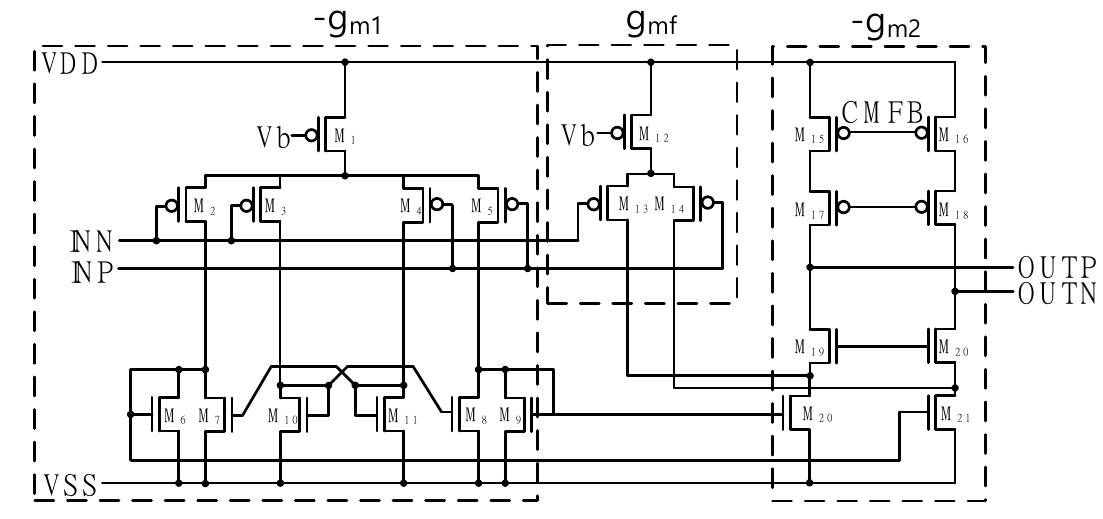
Figure 5. A schematic of the proposed OTA.